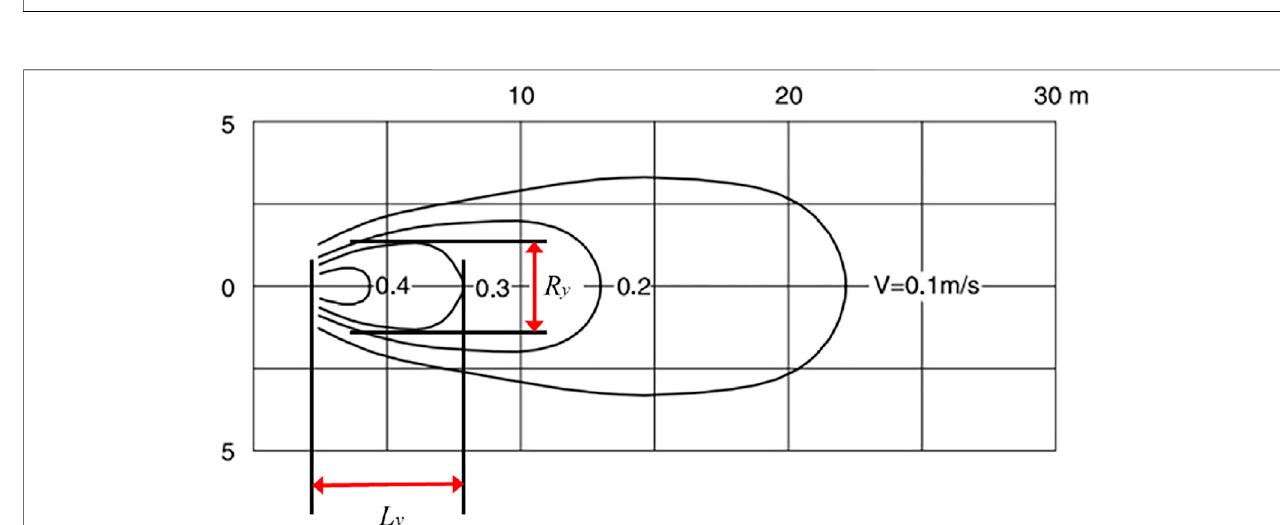
FIGURE 2 | Structural diagram of submersible mixer.